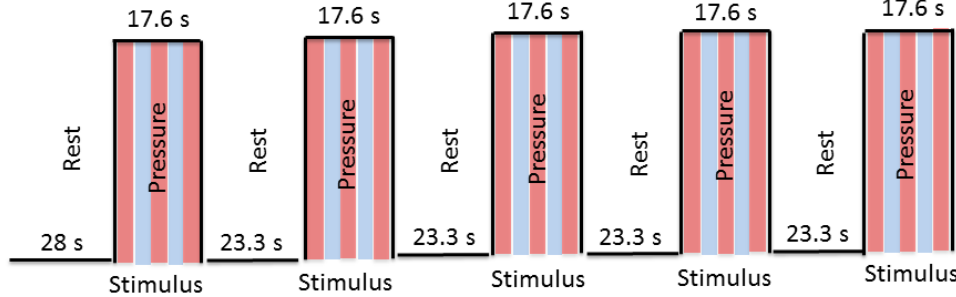
Figure 2. The block design of the study. Red: pressure on 3.33 s; Blue: pressure off 3.33 s.